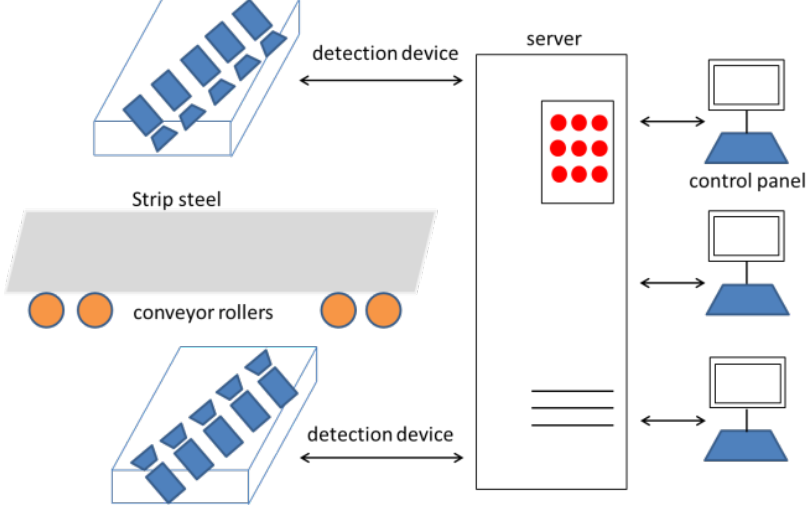
Figure 3. The strip surface defect detection